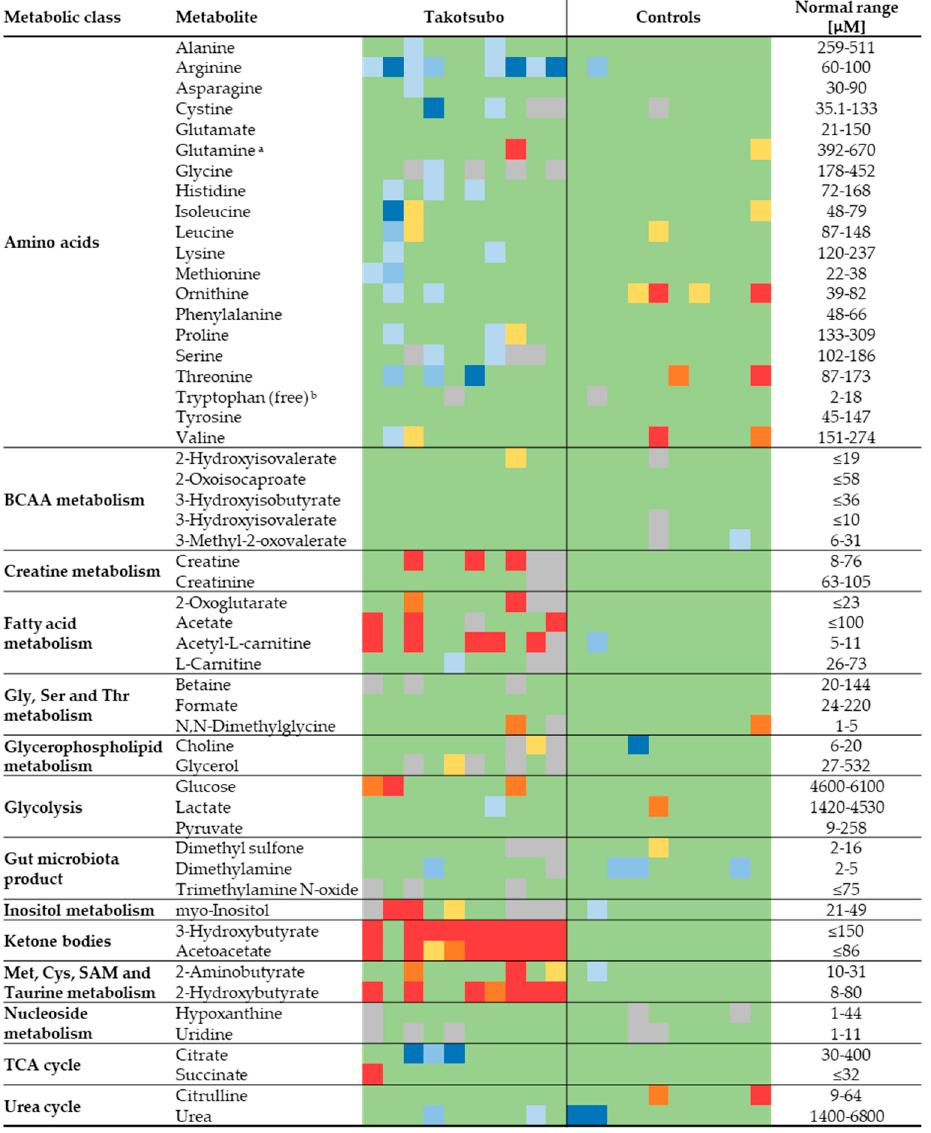
Figure 4. Heatmap showing the general agreement between the measured value for 53 metabolites in each TTS and CTRL sample and the ranges found in the literature. Values in green lie within the range or exceed less than 20% of the limits; in yellow, orange, and red, those that exceed 20, 35 and 50% of the maximum, respectively; in blue shades, those lower than 20, 35 and 50% of the minimum. Cells in grey represent missing values. a Sum of glutamine and pyroglutamate (see Section 2). b The normal range refers to the fraction unbound of tryptophan in human blood [27].